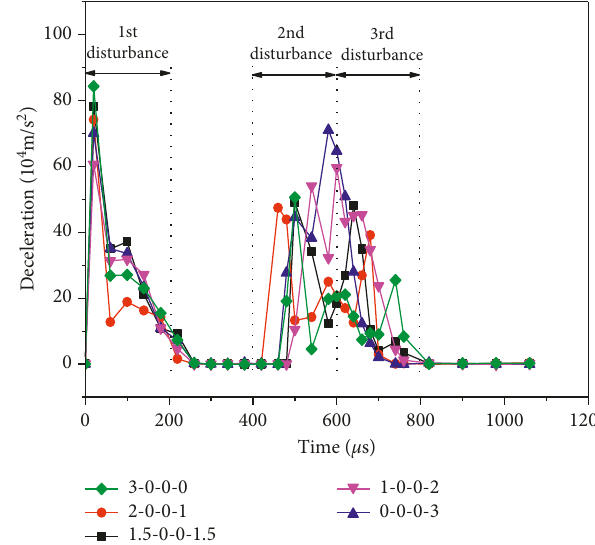
Figure 16: Velocity-time curves of projectile perforating seg- mented targets with different steel liner layouts.